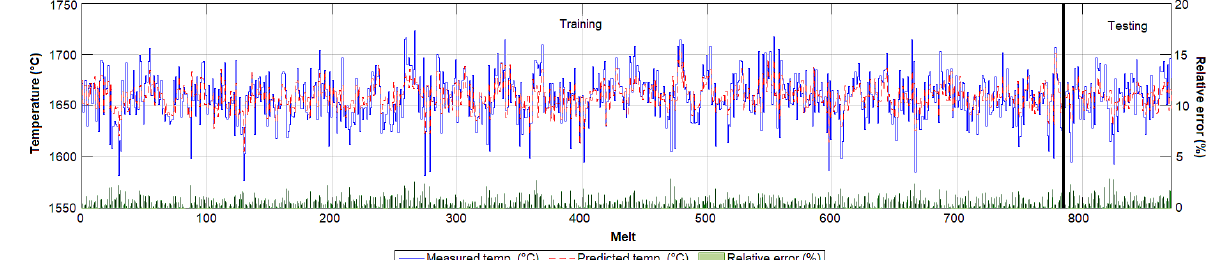
Figure 10. Prediction of endpoint melt temperature by k -NN model.